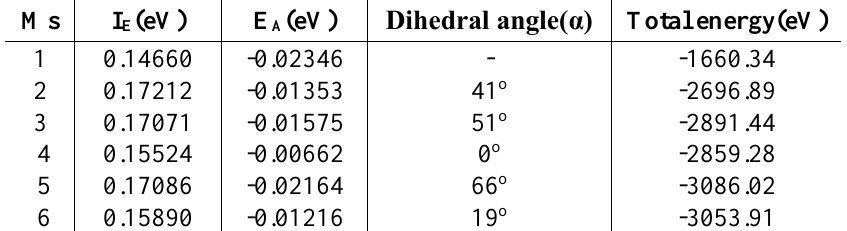
, Electron Affinity E E of family molecular